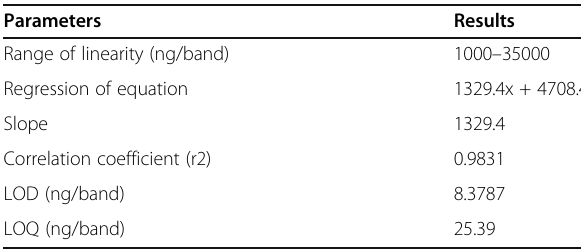
Table 6 Method validation parameters for the quantification of